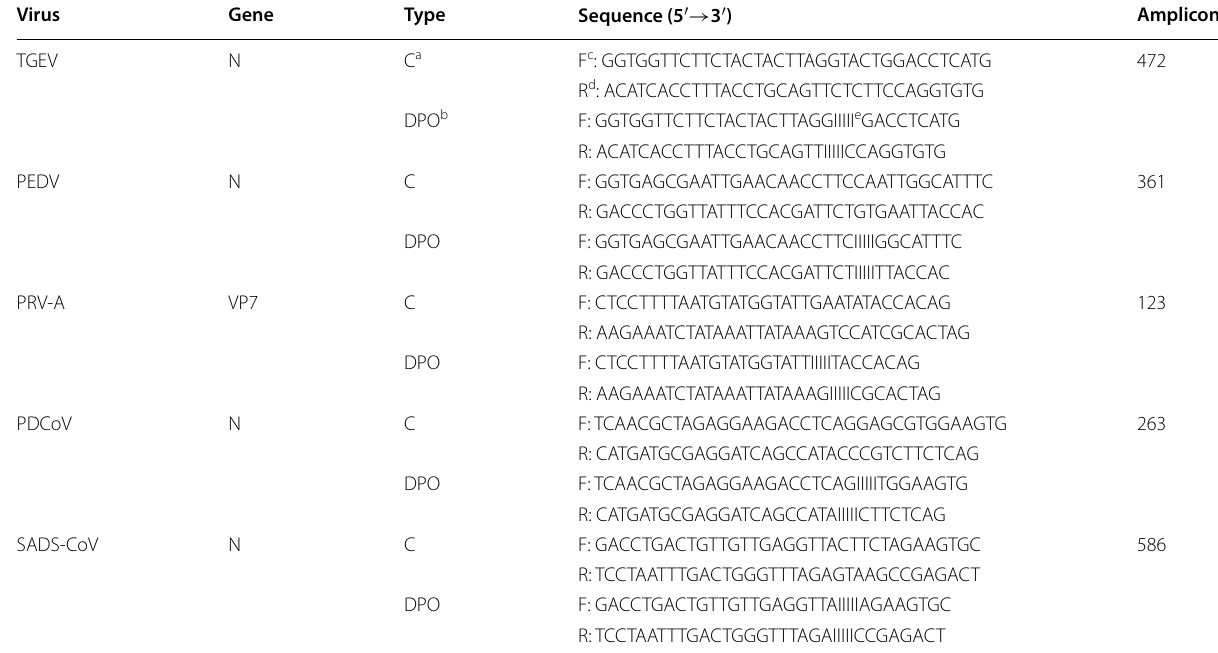
Table 1 Details of the conventional primers and the DPO primers used in this